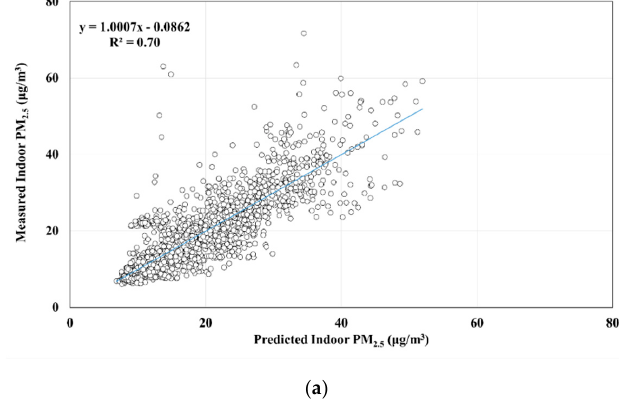
Figure 4. Relationship between predicted and measured hourly average indoor PM 2.5 concentration across areas: ( a ) urban and ( b ) nonurban areas.